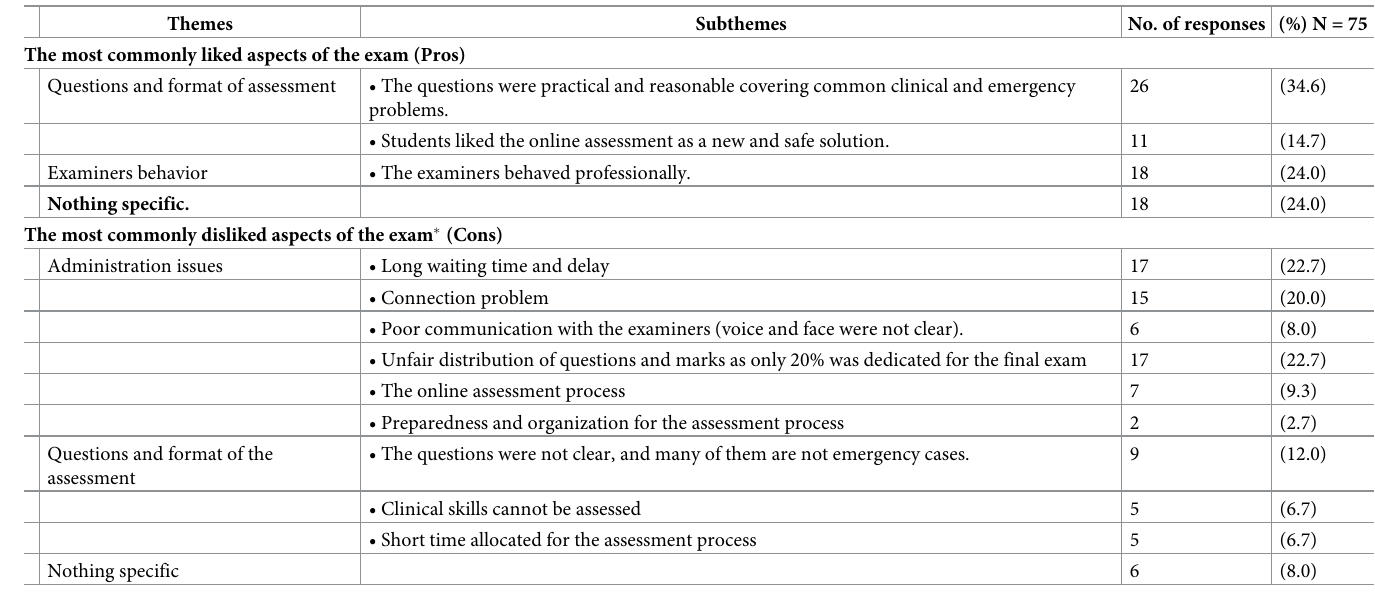
Table 3. Areas that the students like (Pros) and dislike (Cons) regarding the assessment process.